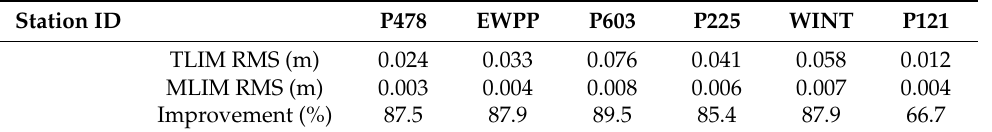
Table 1. The mean RMS and improvement percentage of the interpolated DD tropospheric delay using the TLIM and MLIM at each rover station in Dataset